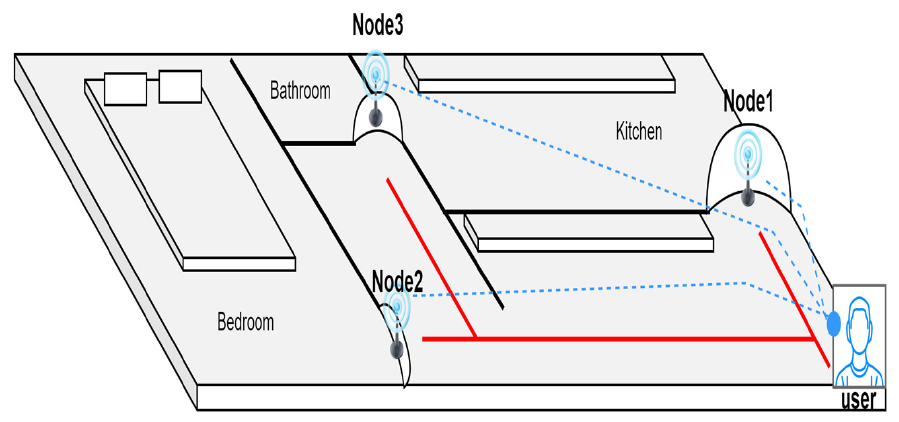
Figure 3. Location nodes of the indoor system.